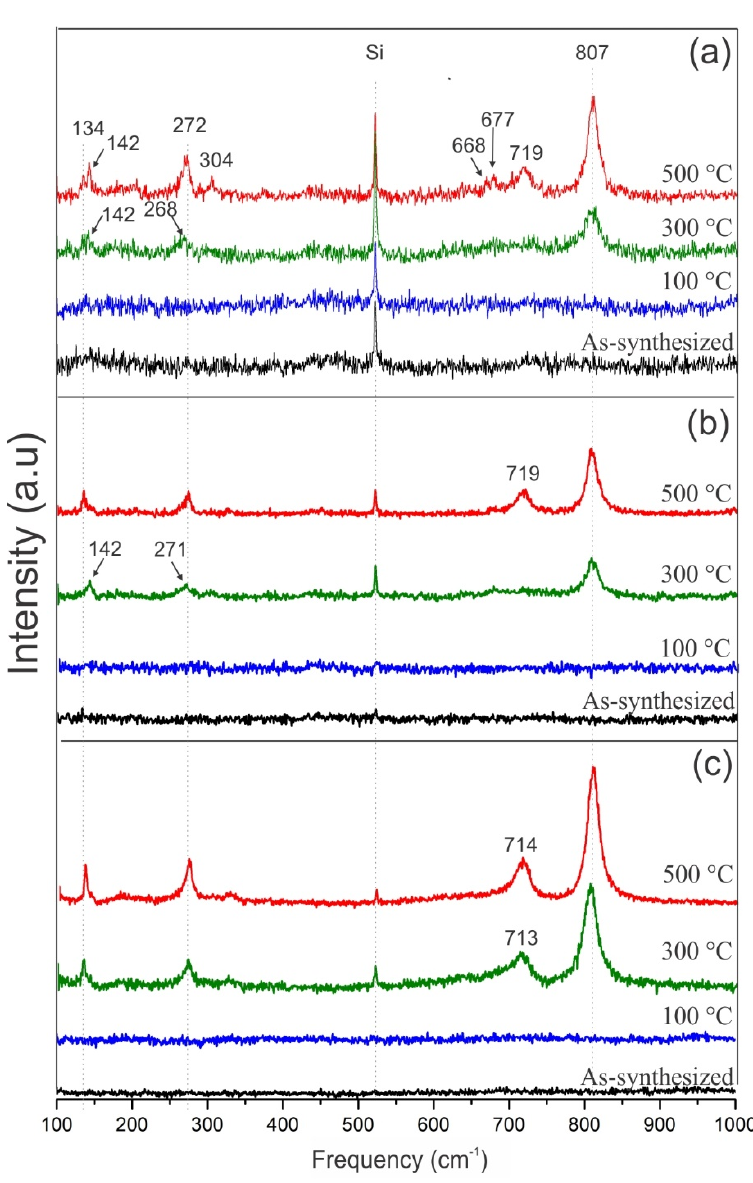
Figure5. Ramanspectraof theas-synthesizedand theannealedsamples: ( a )s5m, ( b )s10m, and( c Figure 5. Raman spectra of the as-synthesized and the annealed samples: ( a ) s5m, ( b ) s10m, and ( c ) s15m.